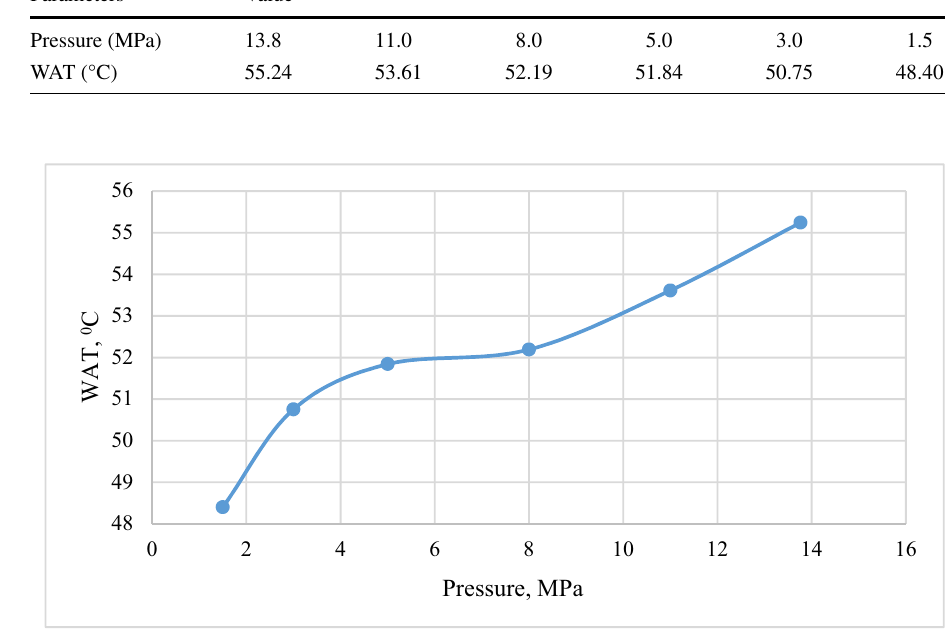
wax appearance temperature on pressure